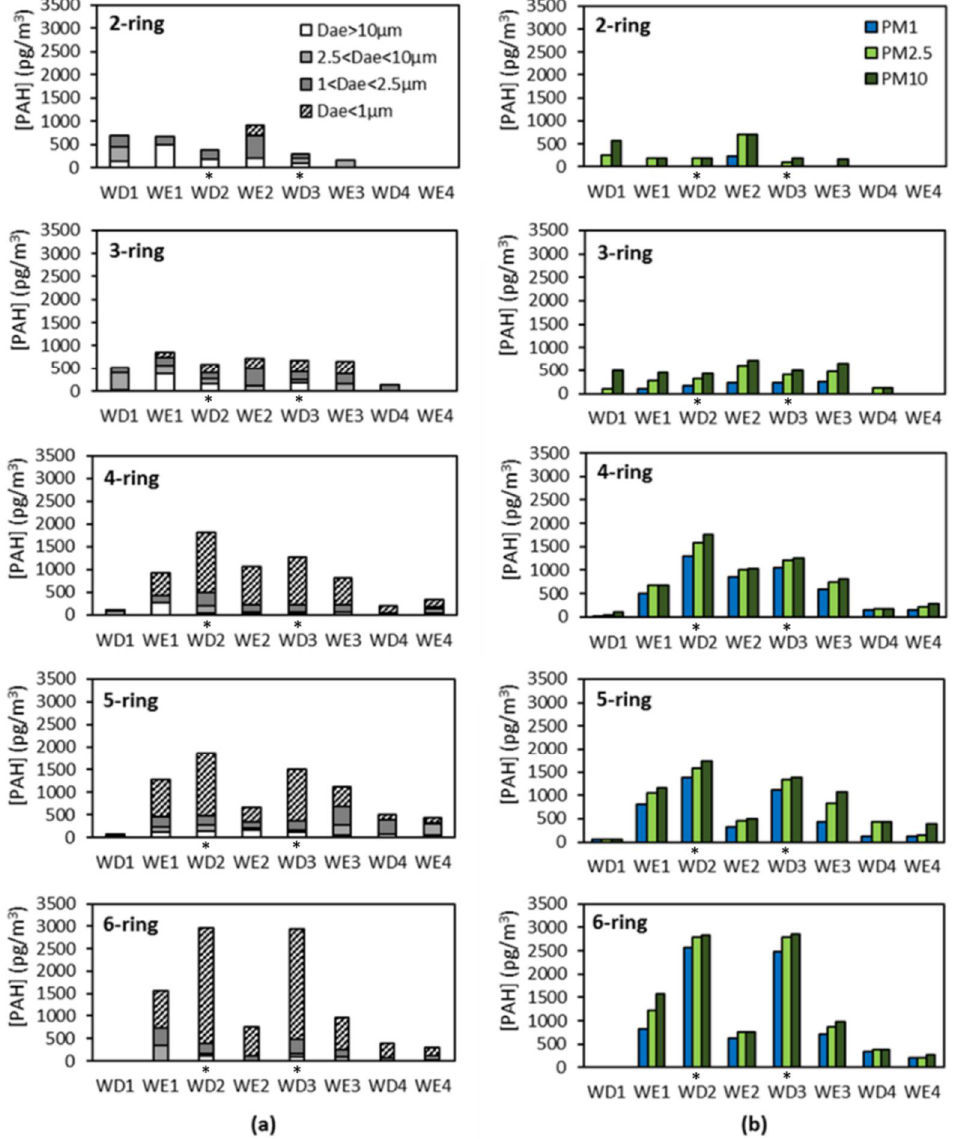
Figure 6. Temporal distribution of PAH by ring number ( a ) corresponding to collection plates (D ae > 10 µm, 10 µm > D ae > 2.5 µm, and 2.5 µm > D ae > 1 µm), and ( b ) corresponding to PM fractions (PM 1 , PM 2.5 and PM 10 ). (* used to indicate the sampling periods when the pollution episodes occurred.).